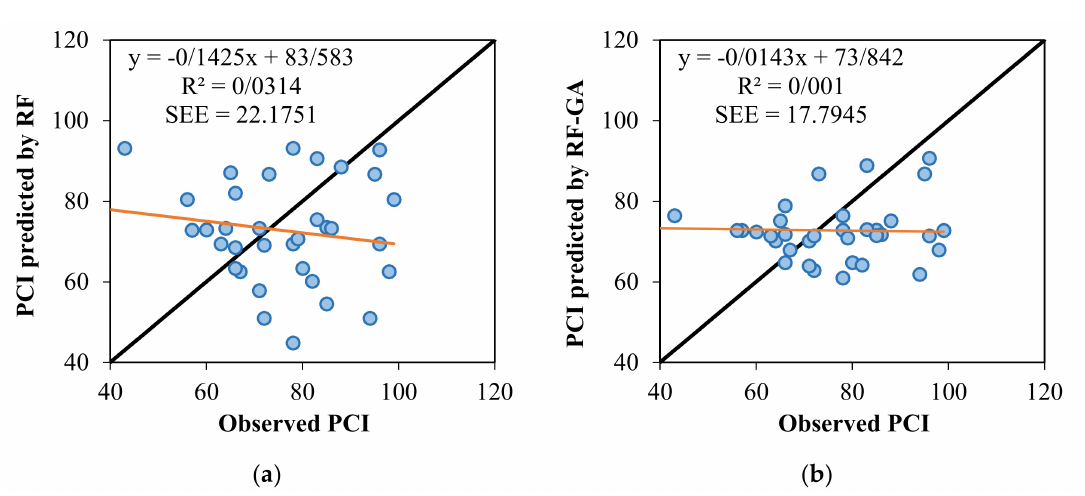
Figure 6. The scatter plots of calculated PCI in the experimental phase of the study and predicted PCI with RF and RF-GA models for test data. ( a ) RF; ( b )